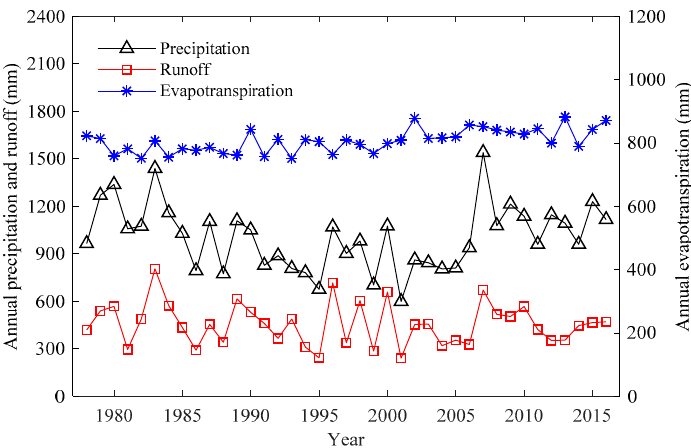
Figure 2. Inter-annual variation and general trend of streamflow and precipitation from 1978 to 2016. (a) Annual runoff (b) Annual